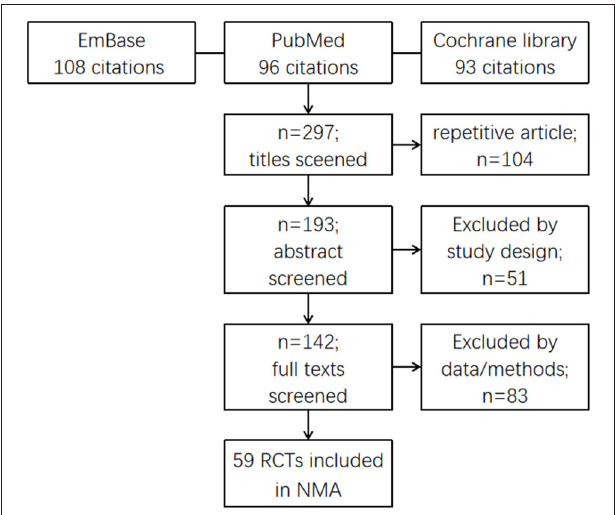
FIGURE 1 | Flow chart showing the screening process of the literature.